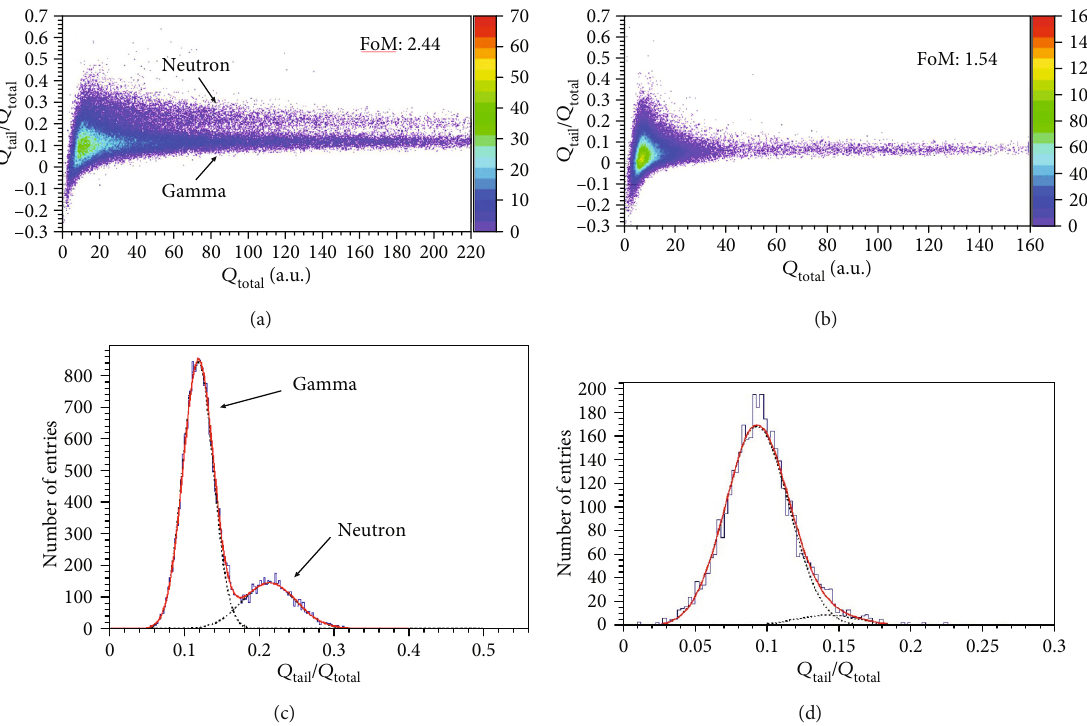
Figure 4: Q / Q value of the samples (a) NE1 and (b) NE3 using the PSD method as a function of energy. The Q tail total varied to optimize the FoM. The NE1 sample enables a relative discrimination of neutron ( n ) and γ -ray signals. It is hard to separate between the neutrons and γ -rays in the NE3 cases. (c, d) The number of entries as a function of Q is fi tted by Gaussian